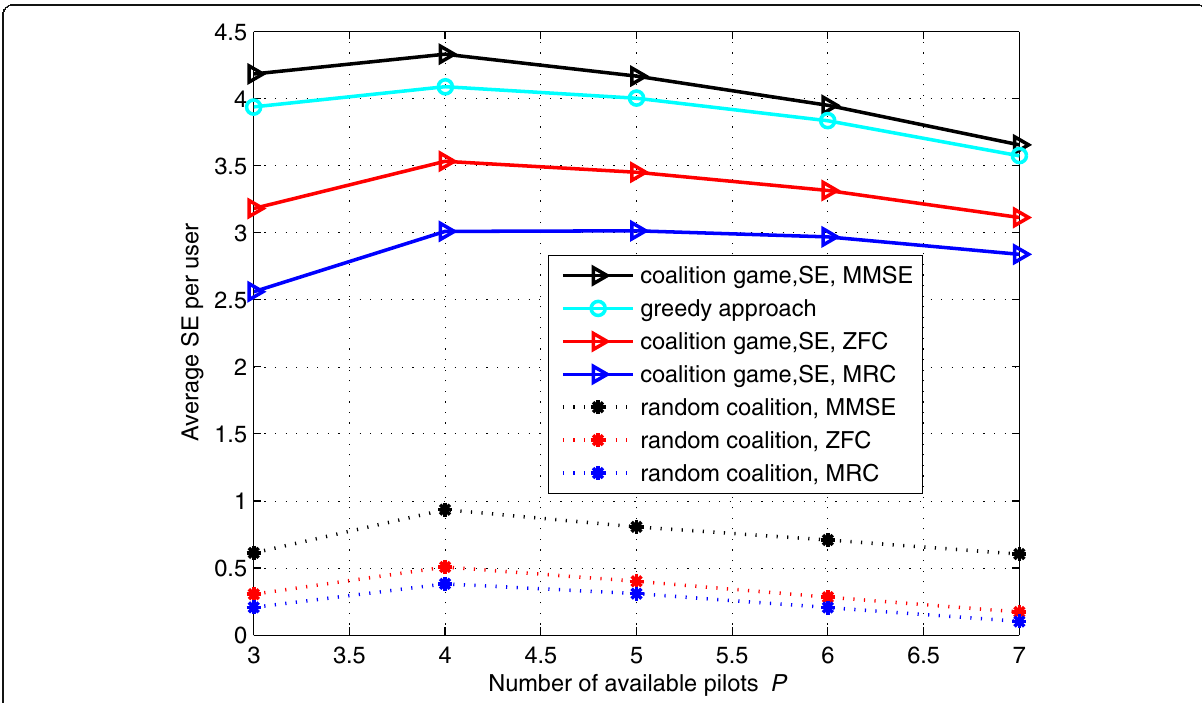
Fig. 12 Average SE versus the number of pilots with T = 20